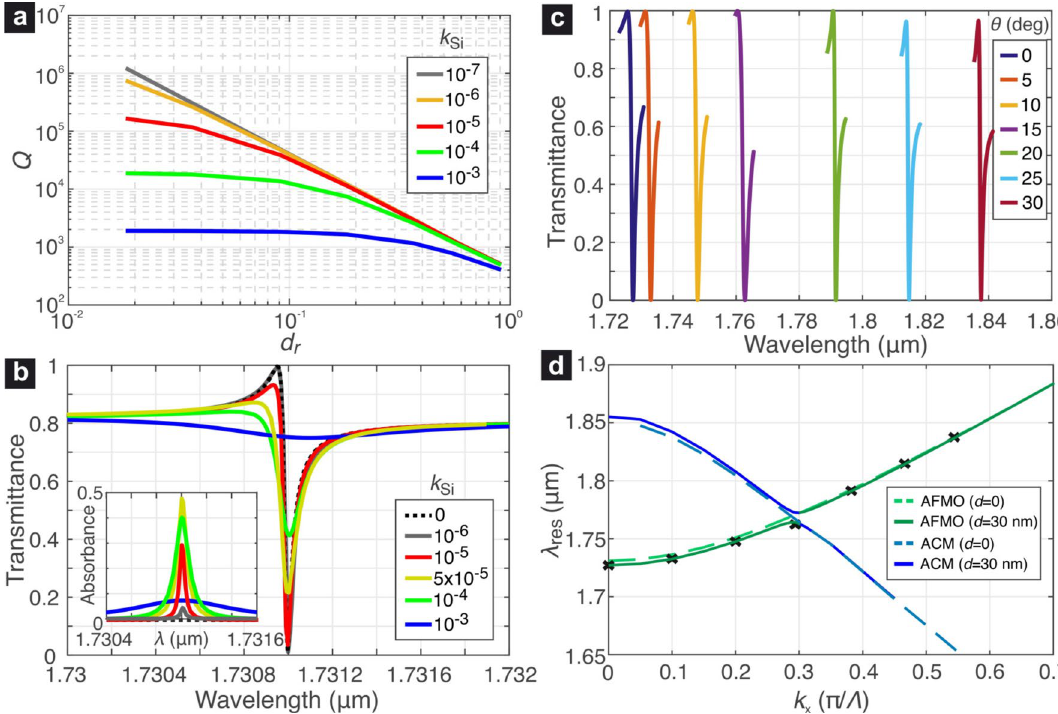
Figure 6. ( a ) Dependence of the Q -factor of the AFMO resonance on k Si . ( b ) Transmittance and absorbance spectra of the AFMO resonance for d = 5 nm and various values of k Si . The spectrum for the lossless case is included as reference. ( c ) Transmittance spectra of the AFMO resonance calculated for oblique incidence with an angle θ = 0 to 30 ◦ in steps of 5 ◦ in the x – z plane and TE-polarized incident planewave. ( d ) Resonant wavelengths calculated by eigenvalue analysis for the AFMO resonance and an interfering mode for the symmetric ( d = 0 ) and an asymmetric metasurface ( d = 30 nm), showing avoided mode crossing in the perturbed